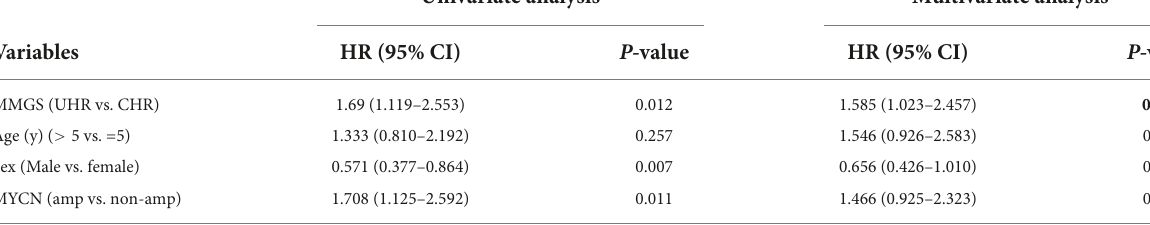
TABLE 1 Univariate and multivariate analyses of MMGS model in the SEQC HRNB cohort. Univariate analysis Multivariate analysis